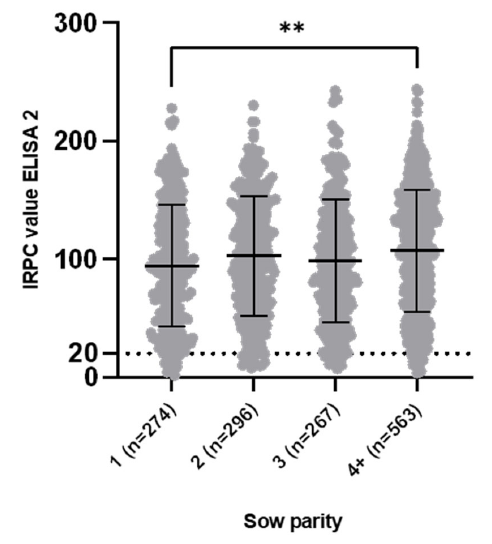
Figure 2. ELISA 2 (CIVTEST SUIS PRRS E/S) Relative Index Percent (IRPC) values in 1400 sow samples (parity 1 = 274, parity 2 = 296, parity 3 = 267 and parity 4+ = 563) originating from 70 Belgian sow herds that practice routine vaccination against Porcine Reproductive and Respiratory Syndrome virus (PRRSv). Data are shown as individual IRPC values, with error bars indicating the mean IRPC value and standard deviation for each parity. Cut ‐ off value for seropositivity (IRPC > 20) is shown as a dotted line. A significant difference in mean IRPC value between parity 1 and parity 4+ sow was found ( p = 0.004). Despite routine PRRSv vaccination, 14/274 (parity 1), 15/296 (parity 2), 11/267 (parity 3) and 18/563 (parity 4+) sows were seronegative in ELISA 2. The proportion of seronegative sows was not significantly different between parities ( p = 0.47). ** p <